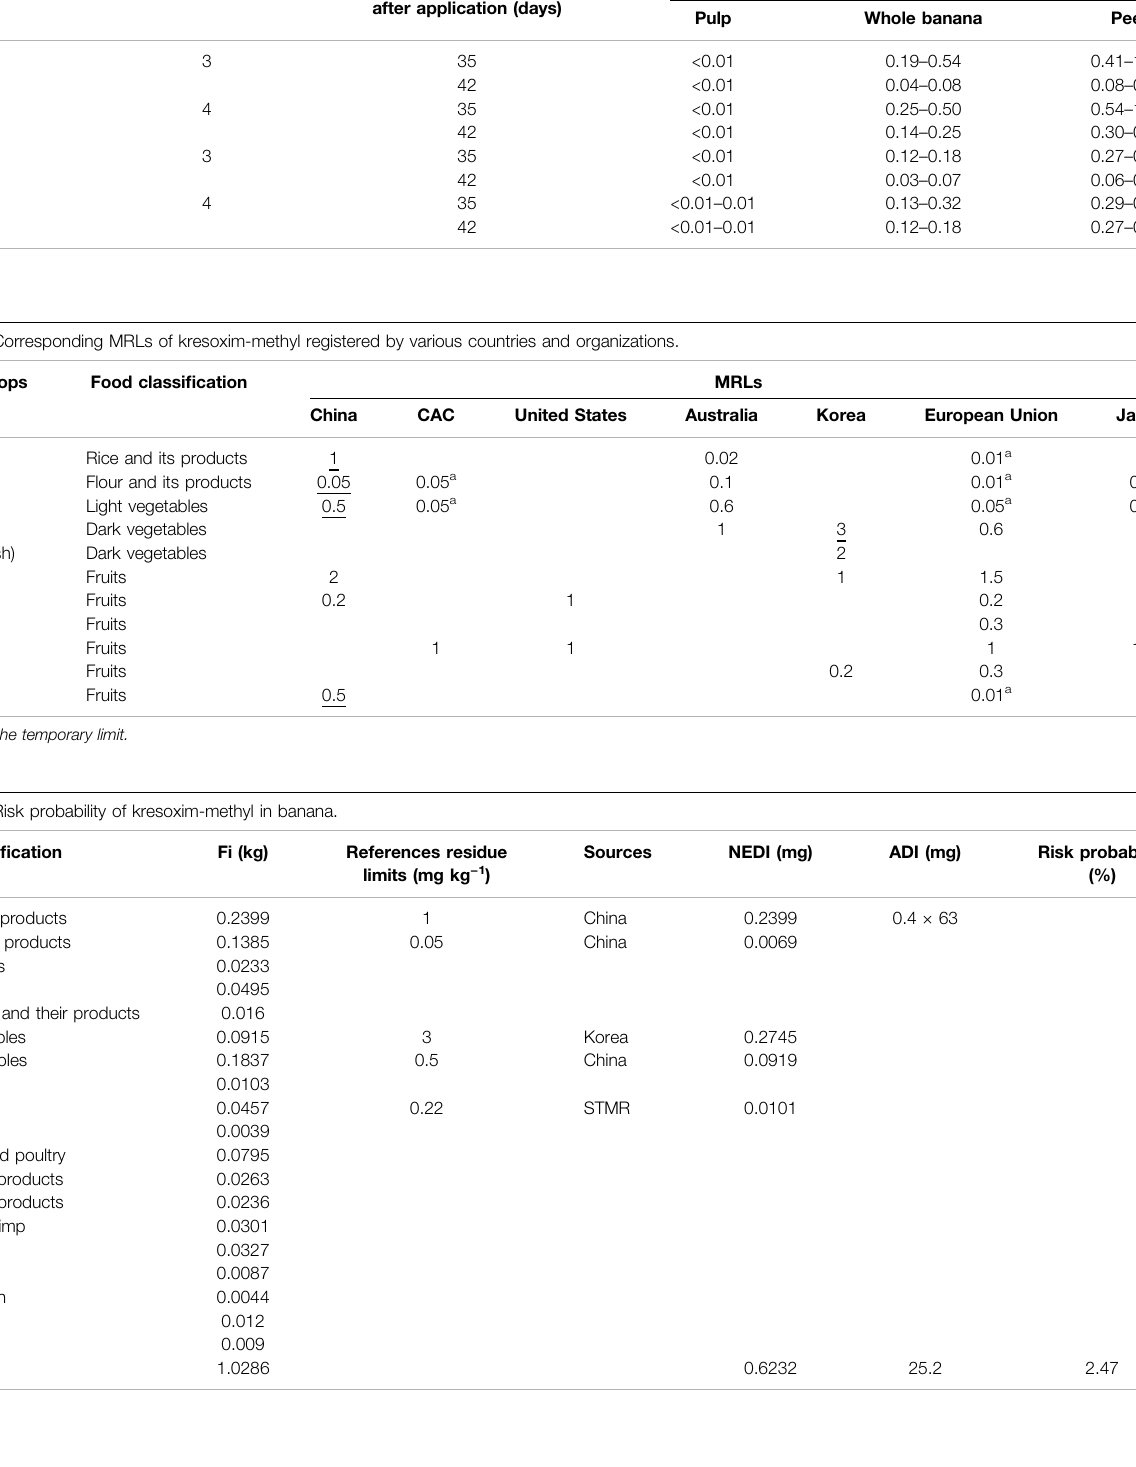
TABLE 3 | Distribution of kresoxim-methyl in pulp, the whole banana, and peel. Experiment spot